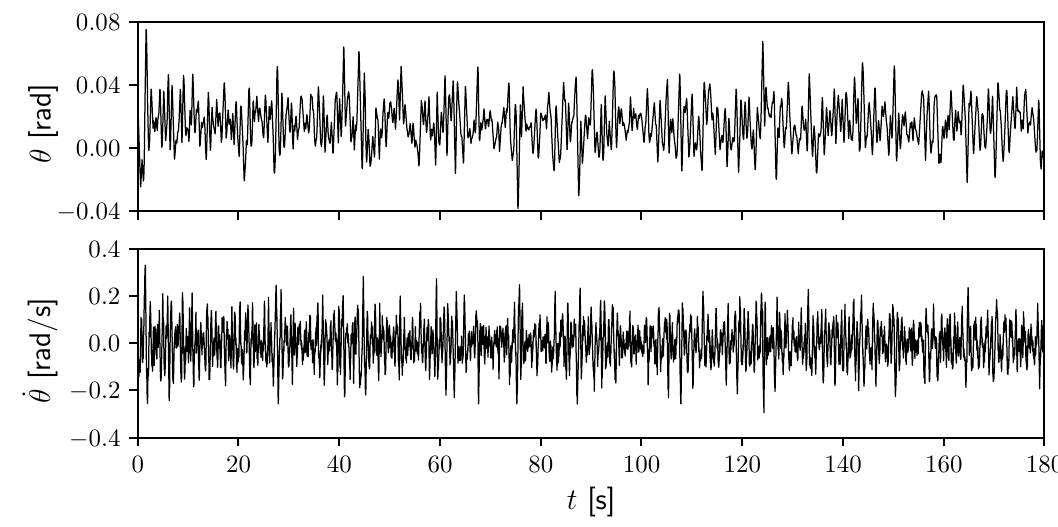
Figure 3. The measured time series of the human–bicycle balance for ( s , n ) = ( 1,1 ) . As shown in the upper graph of Figure 3, the vibrational center of θ ( t ) is shifted from the origin, θ = 0. This is mainly because the calibrated θ = 0 does not indicate the vertical equilibrium of the